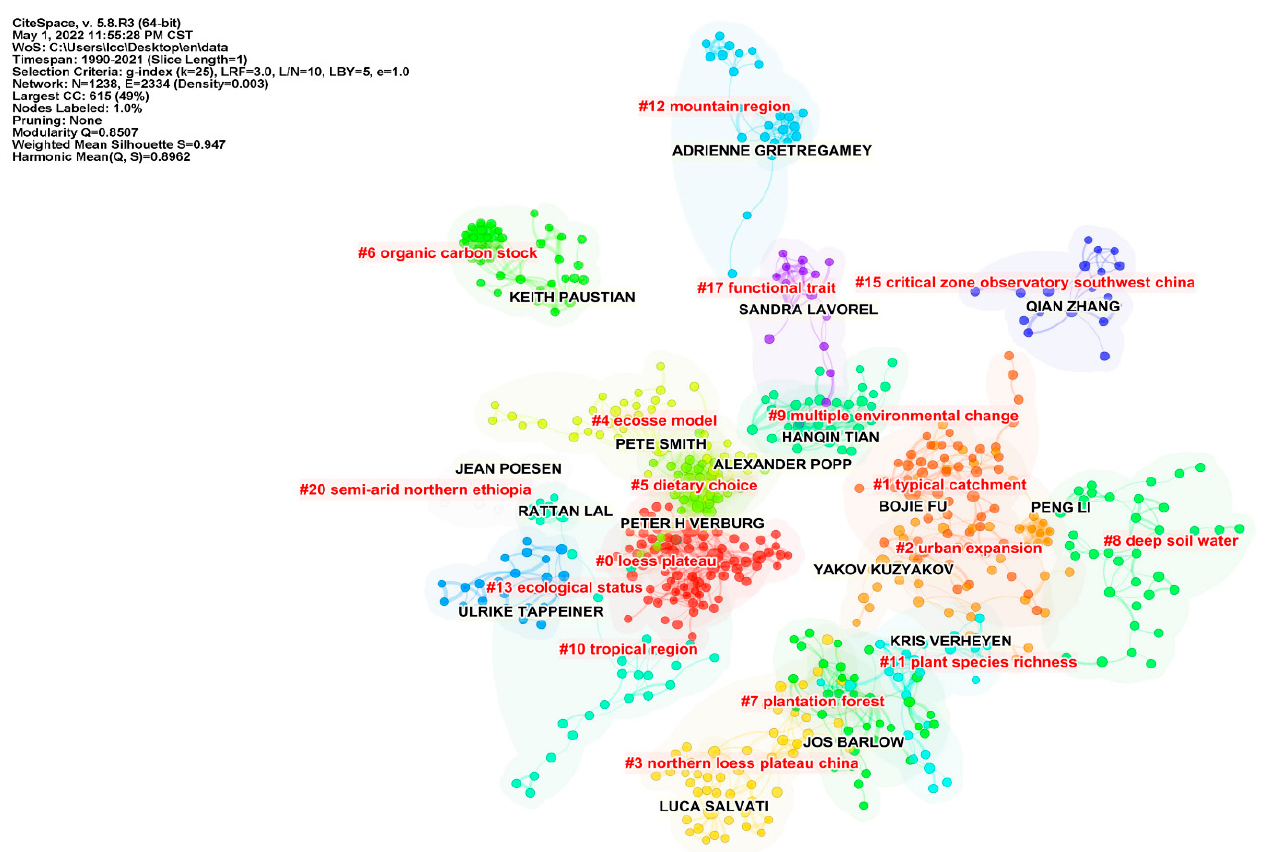
Figure 6. Map of the high–yield author cooperation network.